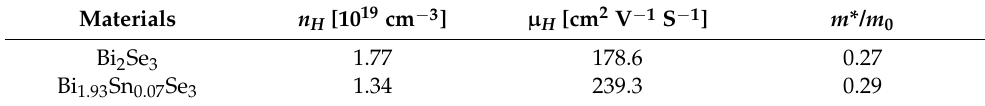
Table 1. Room temperature transport properties and m * of the Bi 2 Se 3 and Bi 1.93 Se 0.07 Se 3 pellets.